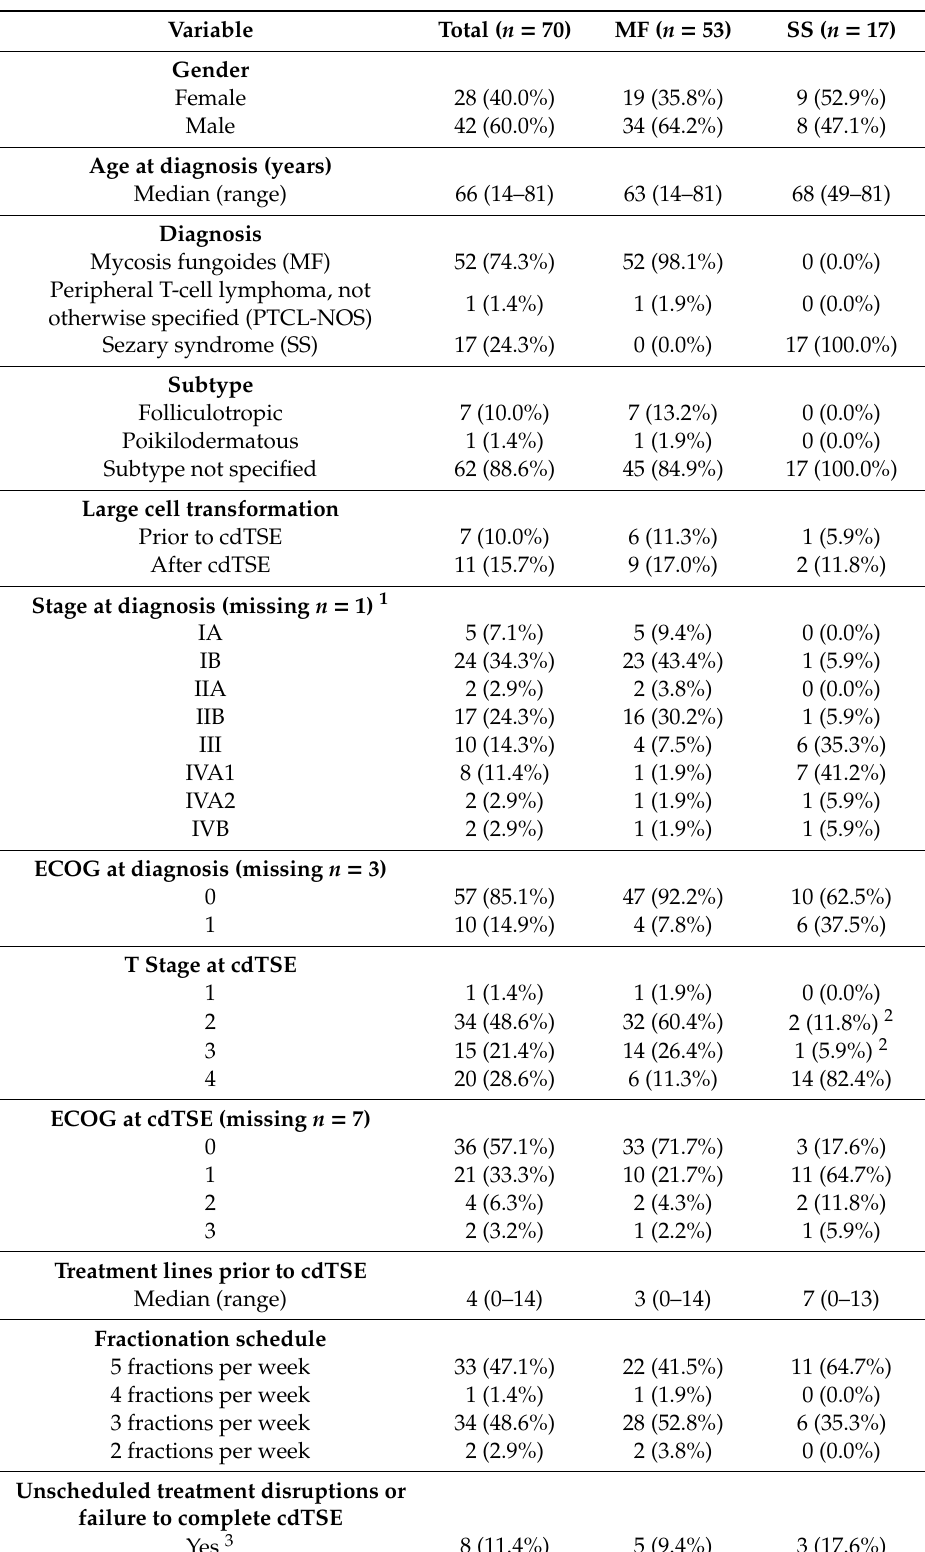
Table 1. Patient, tumour and treatment